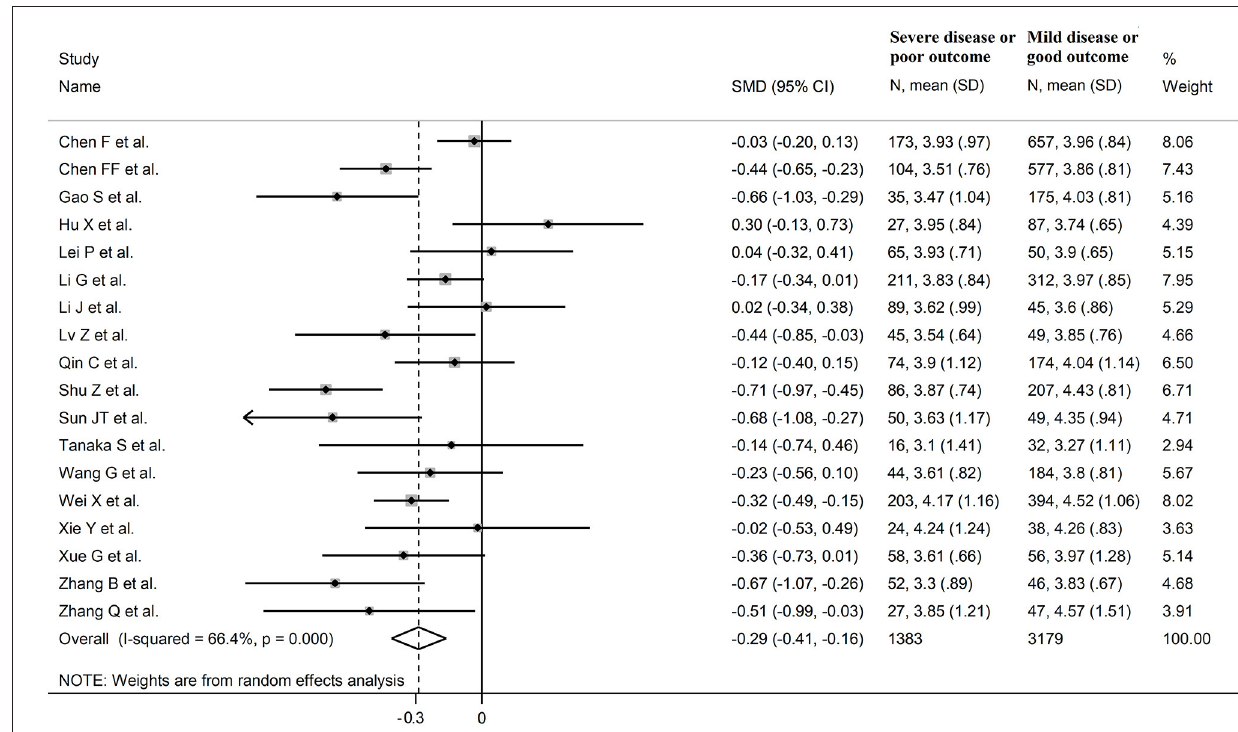
FIGURE 2 | Forest plot of studies examining total cholesterol concentrations in COVID-19.